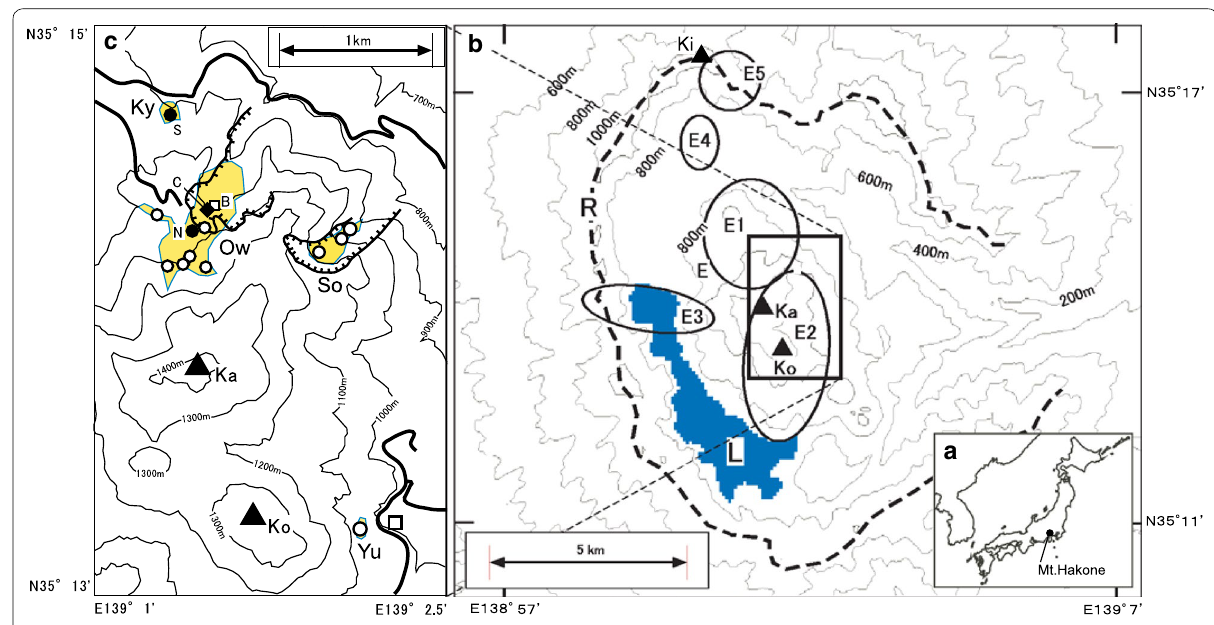
Fig. 1 Location of Hakone volcano and the sampling points of fumarolic gases. a Map of the Japan and the location of Hakone volcano. b Topographic map of Hakone volcano with caldera structure. The bold dashed curve outlines the caldera rim. L, Ka and Ko represent Lake Ashinoko, Kamiyama central cone and Komagatake central cone, respectively. The ellipses marked E1, E2, E3, E4 and E5 indicate regions of hypocenters of earthquake swarms determined by Hot Springs Research Institute of Kanagawa Prefecture (HSRI). c Solid circles (N and S) indicate the fumaroles where volcanic gas was sampled in this study. Solid diamond (C) is the newly created crater at the eruption in 2015. Open circles and open square indicate location of other fumaroles (circles) and borehole, respectively. Bold lines and curves with teeth indicate the roads and cliffs,